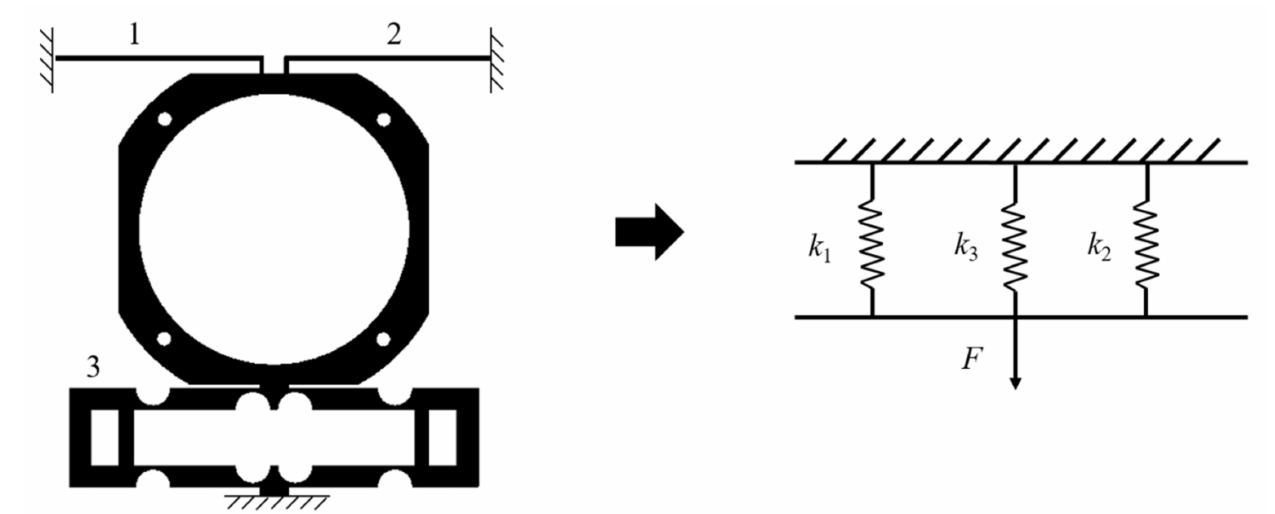
Figure 7. The equivalent stiffness model of the actuating mechanism.